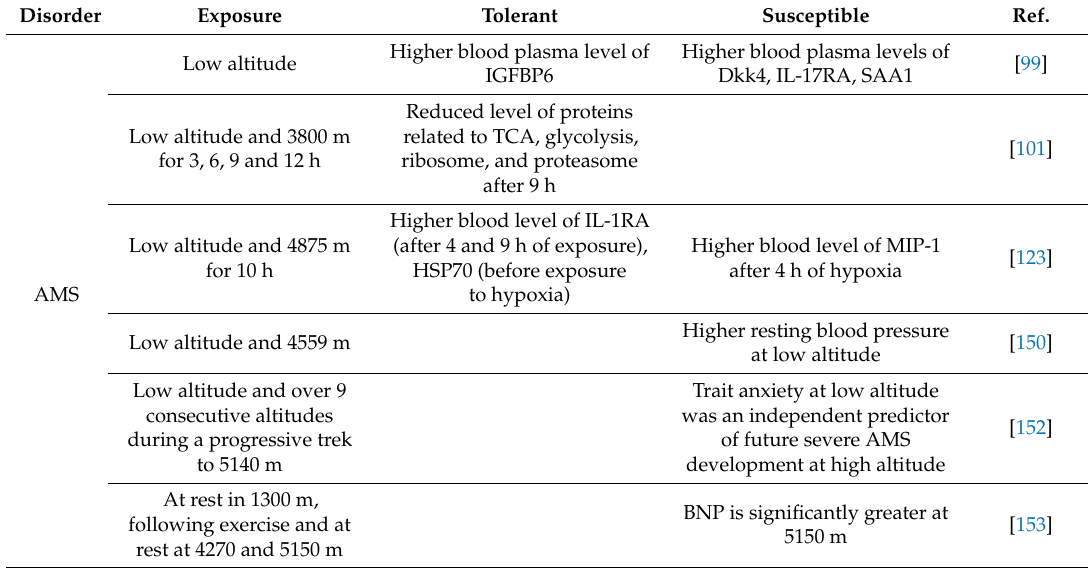
Table 1. Possible biomarkers of people tolerant and susceptible to acute mountain sickness (AMS) and high-altitude pulmonary edema